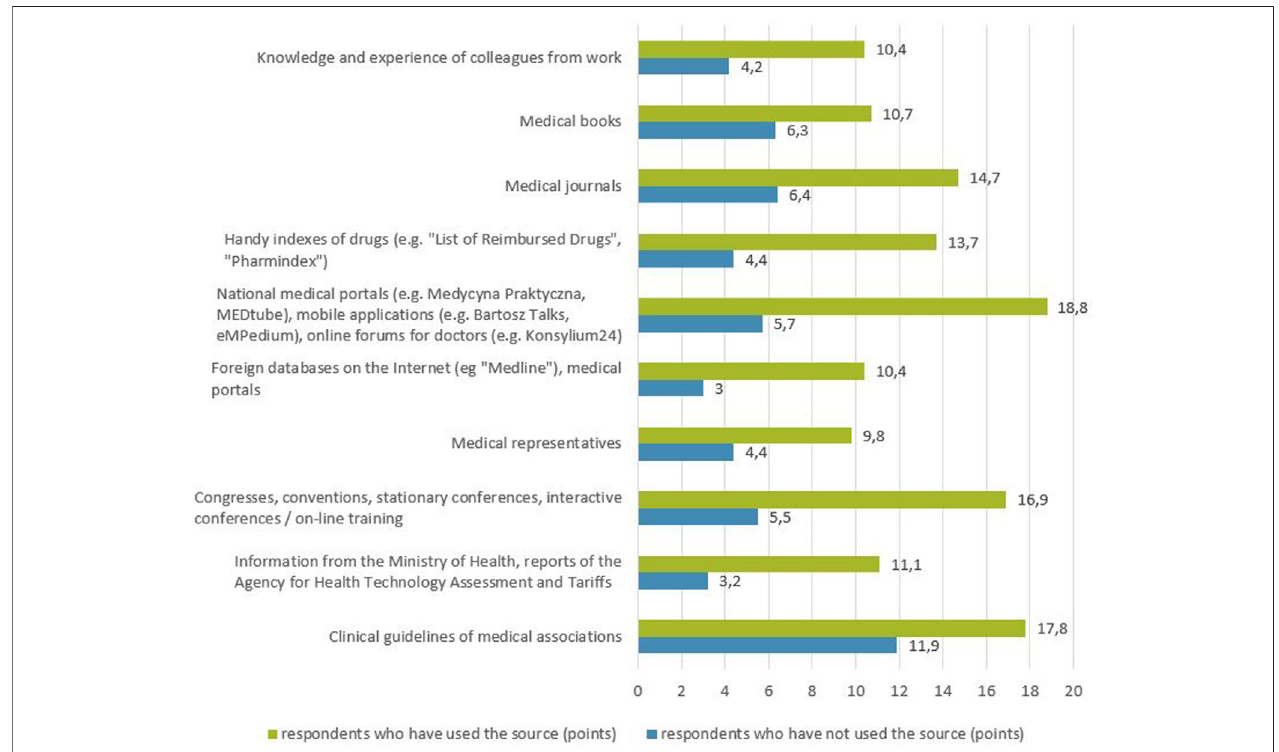
FIGURE 5 | Relationship between the declaration of using a source of information about a medicinal product in the last 6 months and its perceived credibility (points).